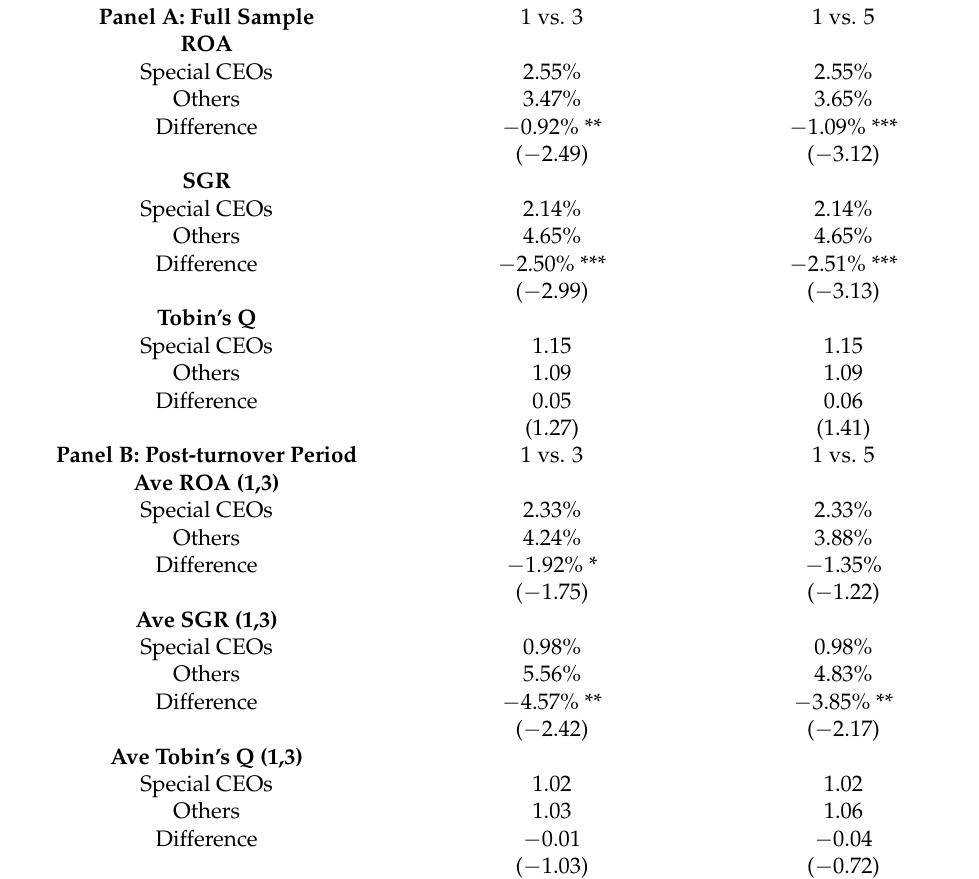
Table 5. Propensity score matching